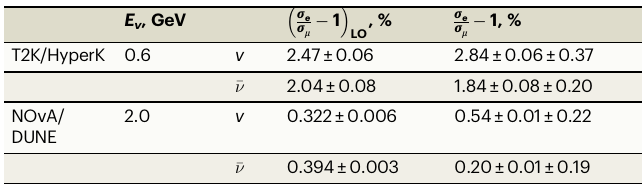
Table 1 | Flavor ratio of inclusive cross